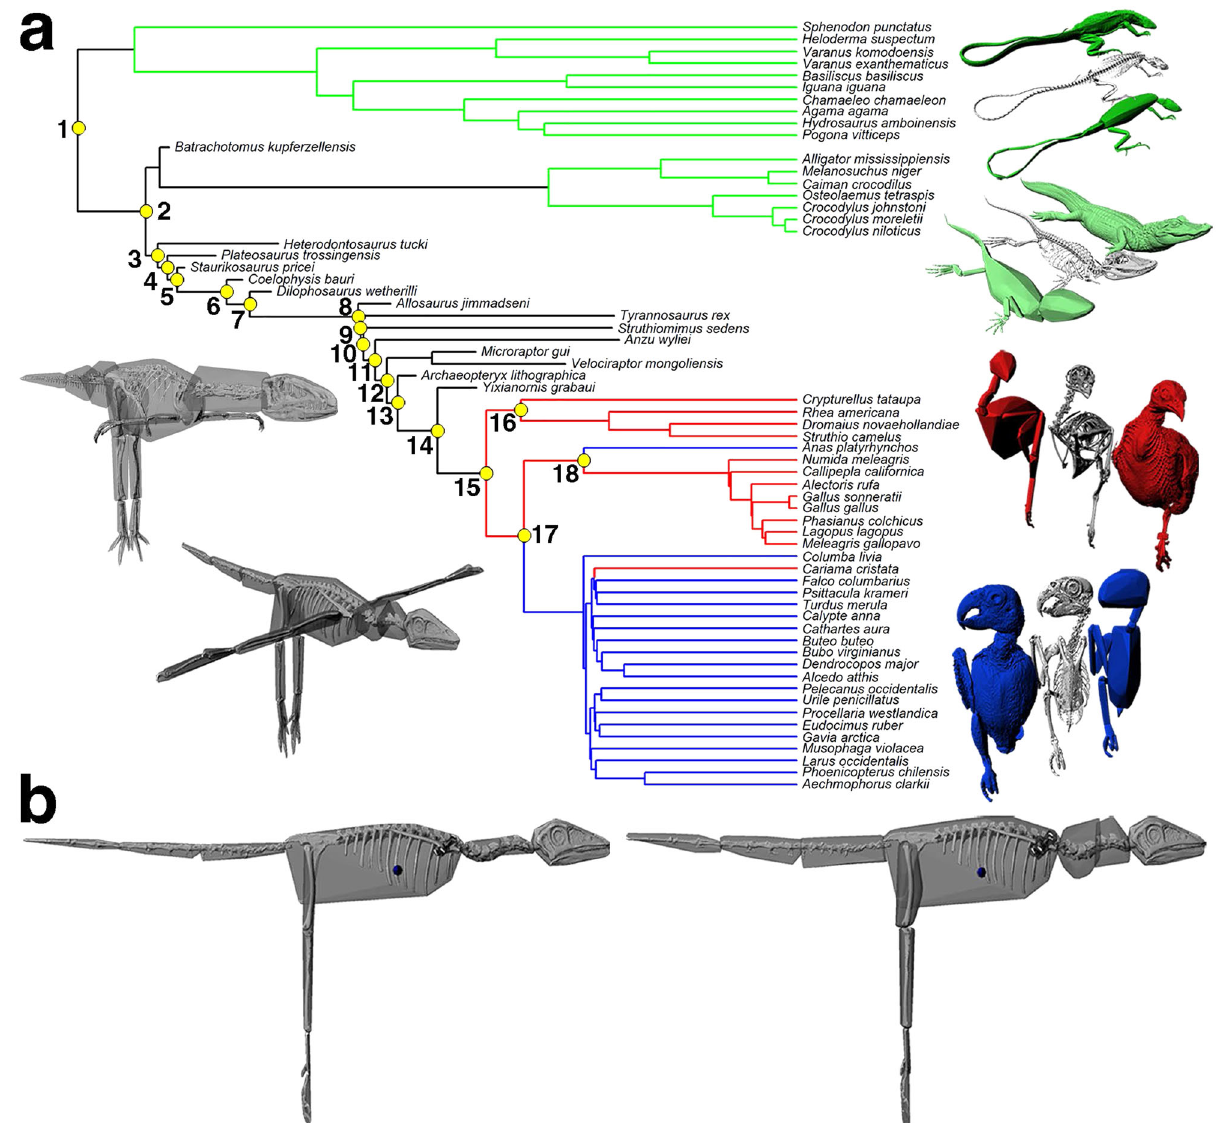
Fig. 1 | Reconstructing body proportions and centre-of-mass in bird-line archosaurs.a Supertree of all taxa in the study, with branch lengths scaled to unit time. The larger yellow circles represent the major reconstructed nodes through avian evolution, and are numbered as followed, 1. Sauropsida, 2. Archosauria, 3. Dinosauria, 4. Saurischia, 5. Theropoda, 6. Neotheropoda, 7. Dilophosaurus + Neotetanurae, 8. Neotetanurae, 9. Coelurosauria, 10. Maniraptoriformes, 11. Pen- naraptora, 12. Eumaniraptora, 13. Avialae, 14. Ornithuromorpha, 15. Neornithes, 16. Palaeognathae, 17. Neognathae, 18. Galloanserae. Three dimensional skeletal, minimum skeletal convex hull and skin volume models were generated from CT scans of 17 extant non-avian sauropsids (green branches), 13 hindlimb-dominated